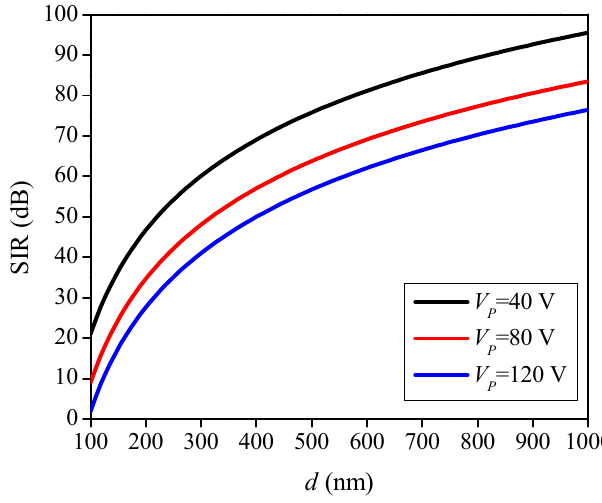
Figure 13. Minimum gap spacing as a function of the DC-bias voltage for EWG ring = − 99 resonator with Q = 8,000 and P i